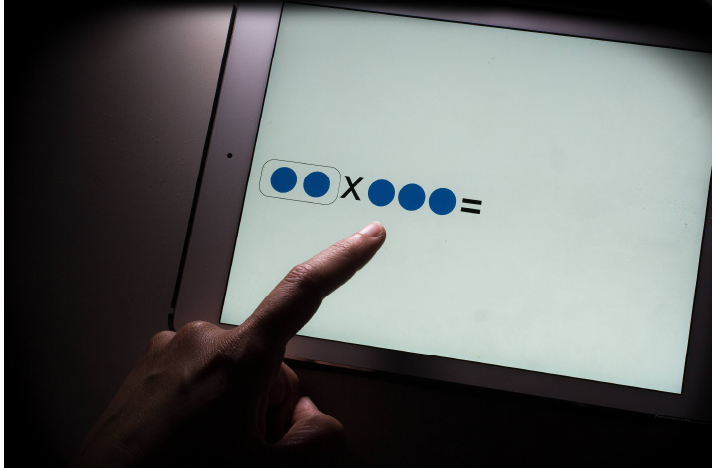
Figure 2. Interactive